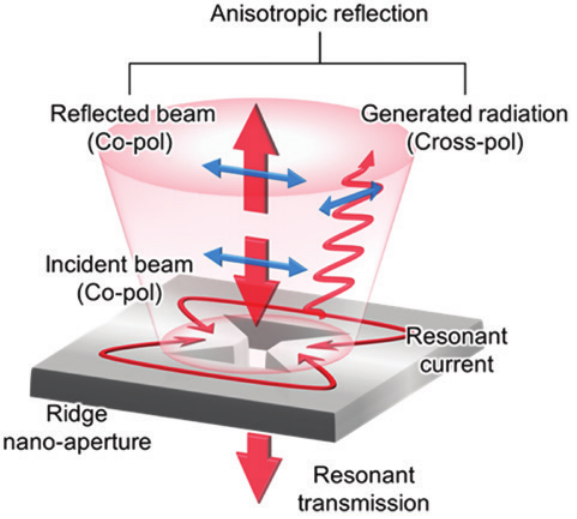
Figure 1: Schematic of the anisotropic reflection from a ridge